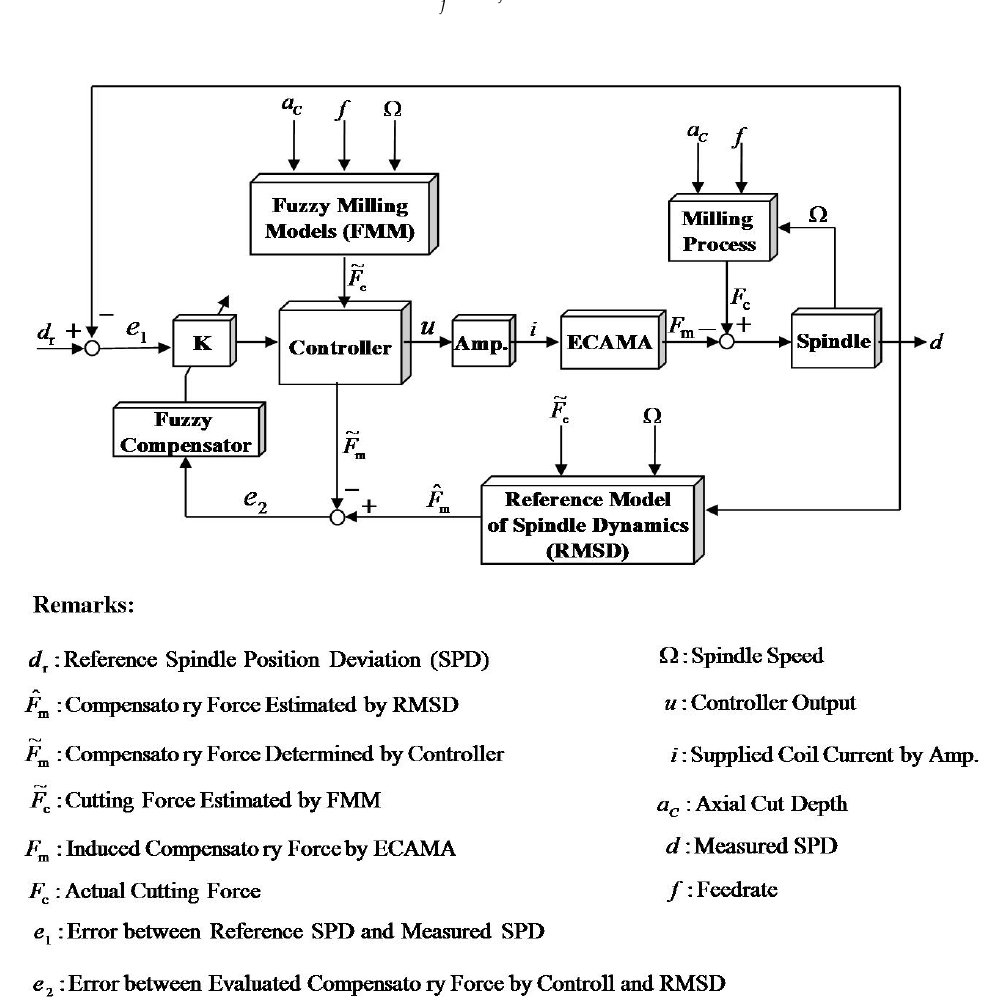
Figure 6. Block diagram of the fuzzy model reference adaptive control system.